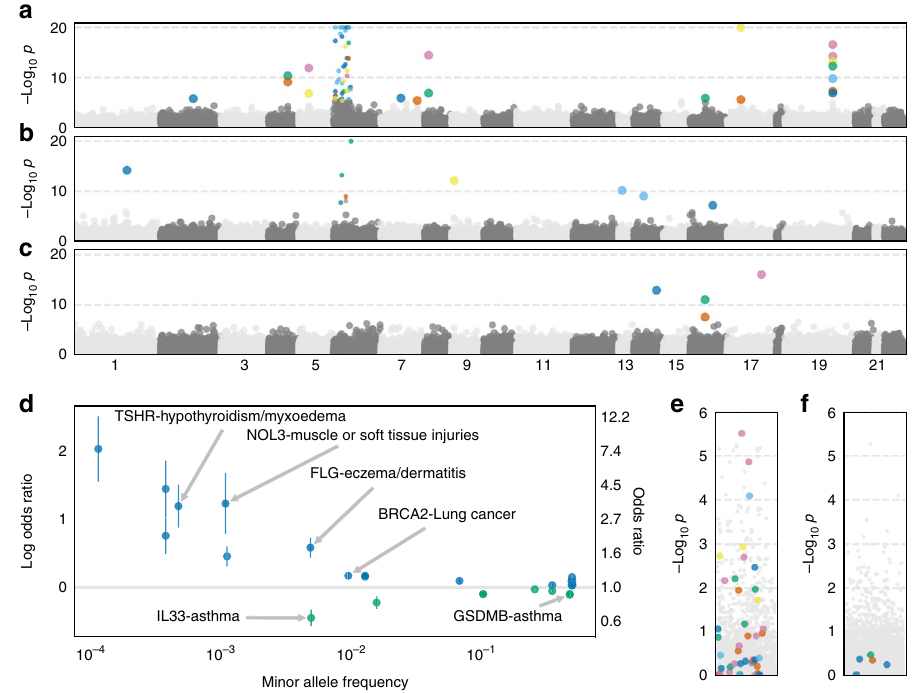
Fig. 2 Identi fi cation of risk and protective alleles for 135 phenotypes. a – c Manhattan plots for logistic regression for all PTVs and all phenotypes strati fi ed by minor allele frequency a > 1%, b between 0.1% and 1%, and c between 0.01% and 0.1%. Scatter points are colored according to phenotype. Fourteen associations with -log 10 p values> 20 were plotted at 20. PTVs in genes near or in the MHC region have smaller scatter points. d Effect size “ cascade plot ” for all associations outside the MHC with BY-adjusted p < 0.05. Error bars represent 95% con fi dence intervals. e – f Manhattan plots for PTVs in or near the MHC with minor allele frequency e > 1% and f between 0.1 and 1%. The p values for gray points are the same as in a and b , respectively. The p values for the color points have been re-calculated conditional on HLA